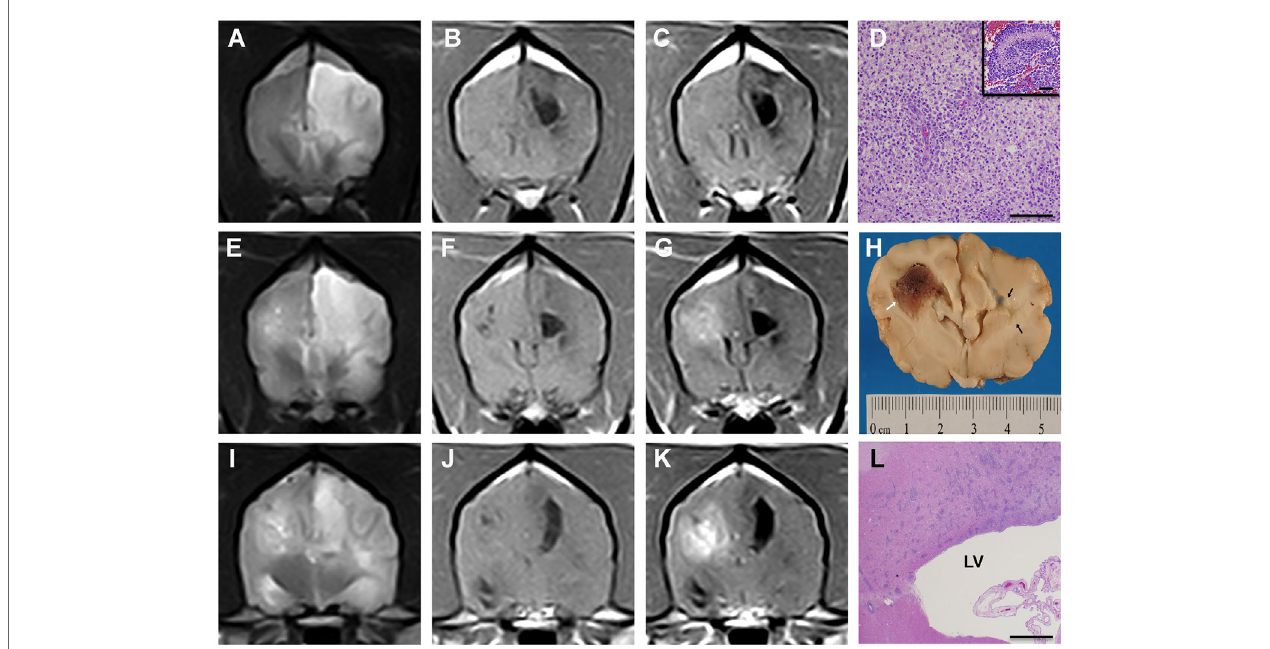
FIGURe 3 | asymmetrical butterfly glioblastoma, Case 2 . Transverse T2 (a,e,I) , T1 (B,F,J) , and post-contrast T1 (C,G,K) MR images from the rostral aspect of the left cerebral lesion (a–C) , the midportion of the lesions (e–G) , and caudal portions of the mass lesions (I–K) . The masses are heterogeneously T1 hypo- to isointense, T2 hyperintense, and the right cerebral lesion demonstrates heterogeneous contrast enhancement. In the rostral aspect of the lesion, T2 hyperintensity extending from the left cerebral mass lesion across midline (a) via the corpus callosum is evident, which was demonstrated to be caused by neoplastic invasion of the corpus callosum at necropsy [ (D) , H&E, bar = 500 μ m]. Morphology of GBM [ (D) , inset] within right cerebral mass illustrating serpentine necrosis and hemorrhage, H&E, bar = 75 μ m. Bilateral mass effect, manifest as lateral ventricular compression and a falx shift to the right is present. Gross brain specimen (H) at the level of the optic chiasm demonstrating mass lesion in right cerebrum (white arrow) and malacia of the subcortical white matter on the left (black arrows). At the caudal level, the left and right intra-axial mass lesions are connected via T2 hyperintensity (I) extending across corpus callosum. Photomicrograph (L) of multifocal infiltration of neoplastic astrocytes within the body of the corpus callosum, H&E stain, bar = 3 mm, LV, left lateral